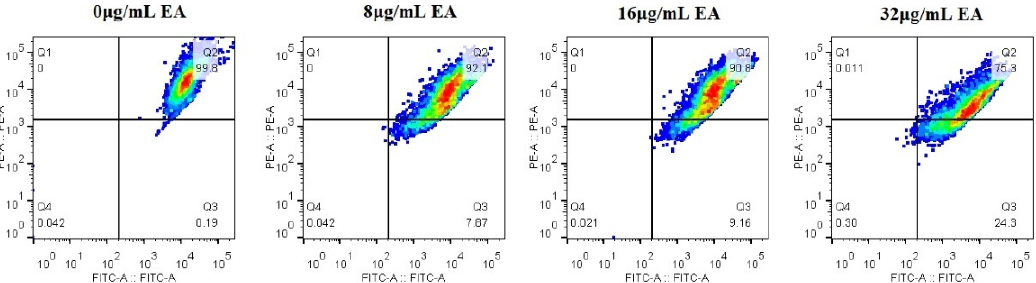
Figure 9. Effect of EA on the mitochondrial membrane potential of C. albicans . The JC-1 staining was